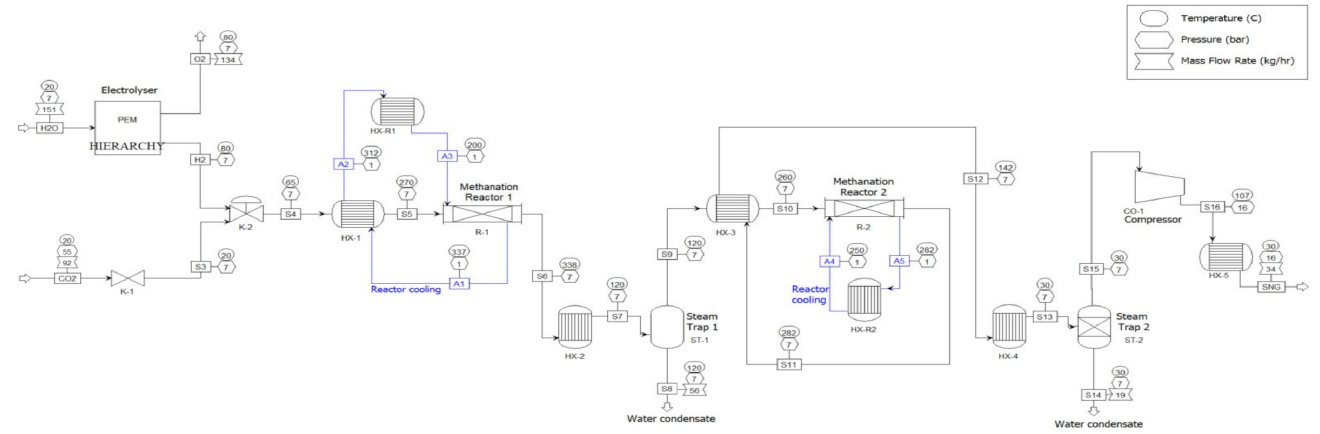
Figure 2. Flowsheet of the PtSNG plant. Flowsheet of the PEM hierarchy block is shown in Figure